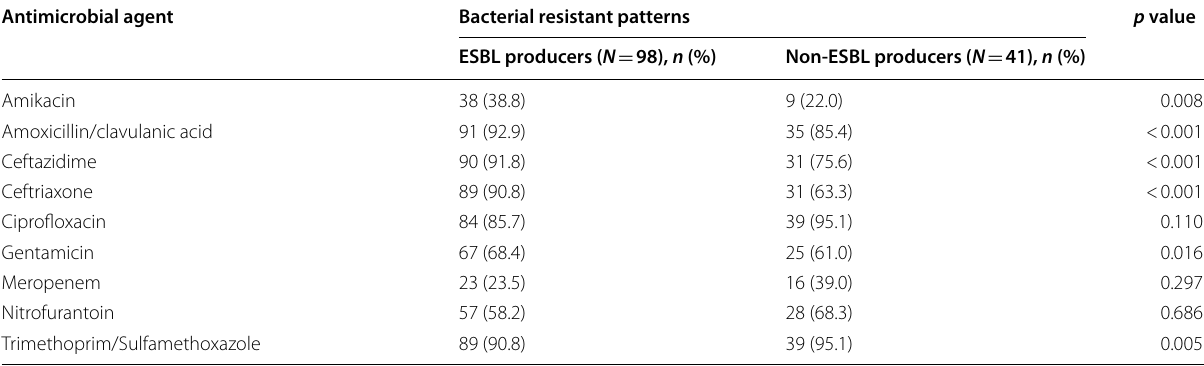
Table 3 Comparison of antimicrobial resistance rate between ESBL and non-ESBL bacterial pathogens causing UTI among men with prostate enlargement at Muhimbili National Hospital, Dar es Salaam-Tanzania Antimicrobial agent Bacterial resistant